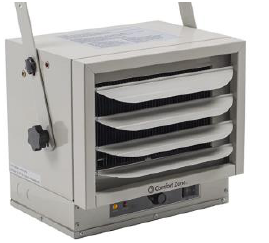
Figure 7. Industrial air heater.